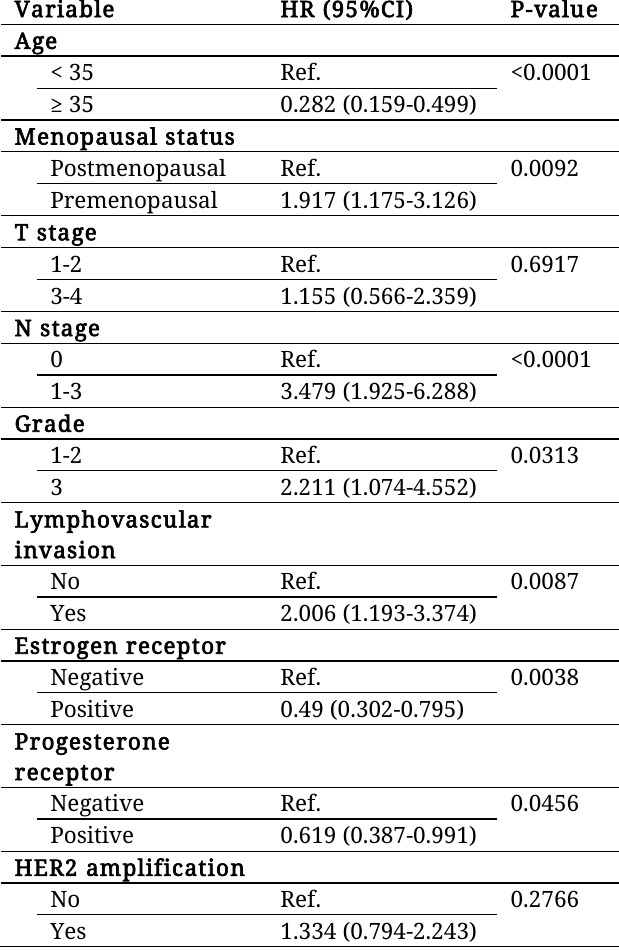
Table 3: Univariate analysis for